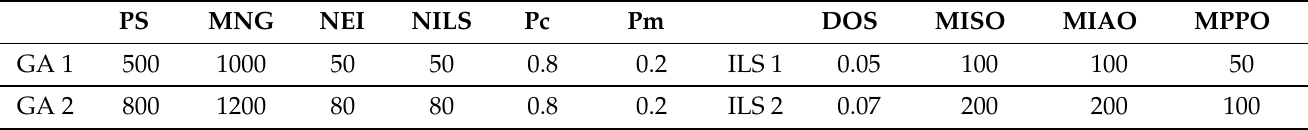
Table 4. Optimal parameters of the genetic and iterated local search